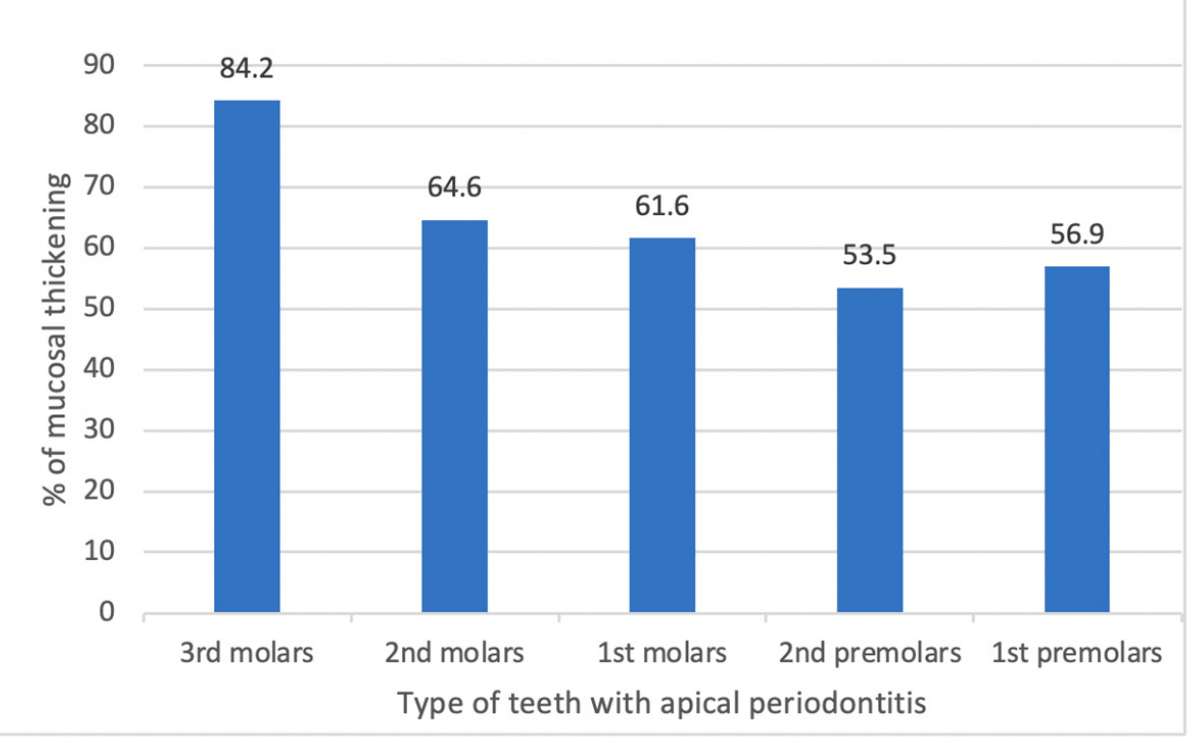
Figure 5. Types of teeth with apical pathology and their relation to sinus pathology.